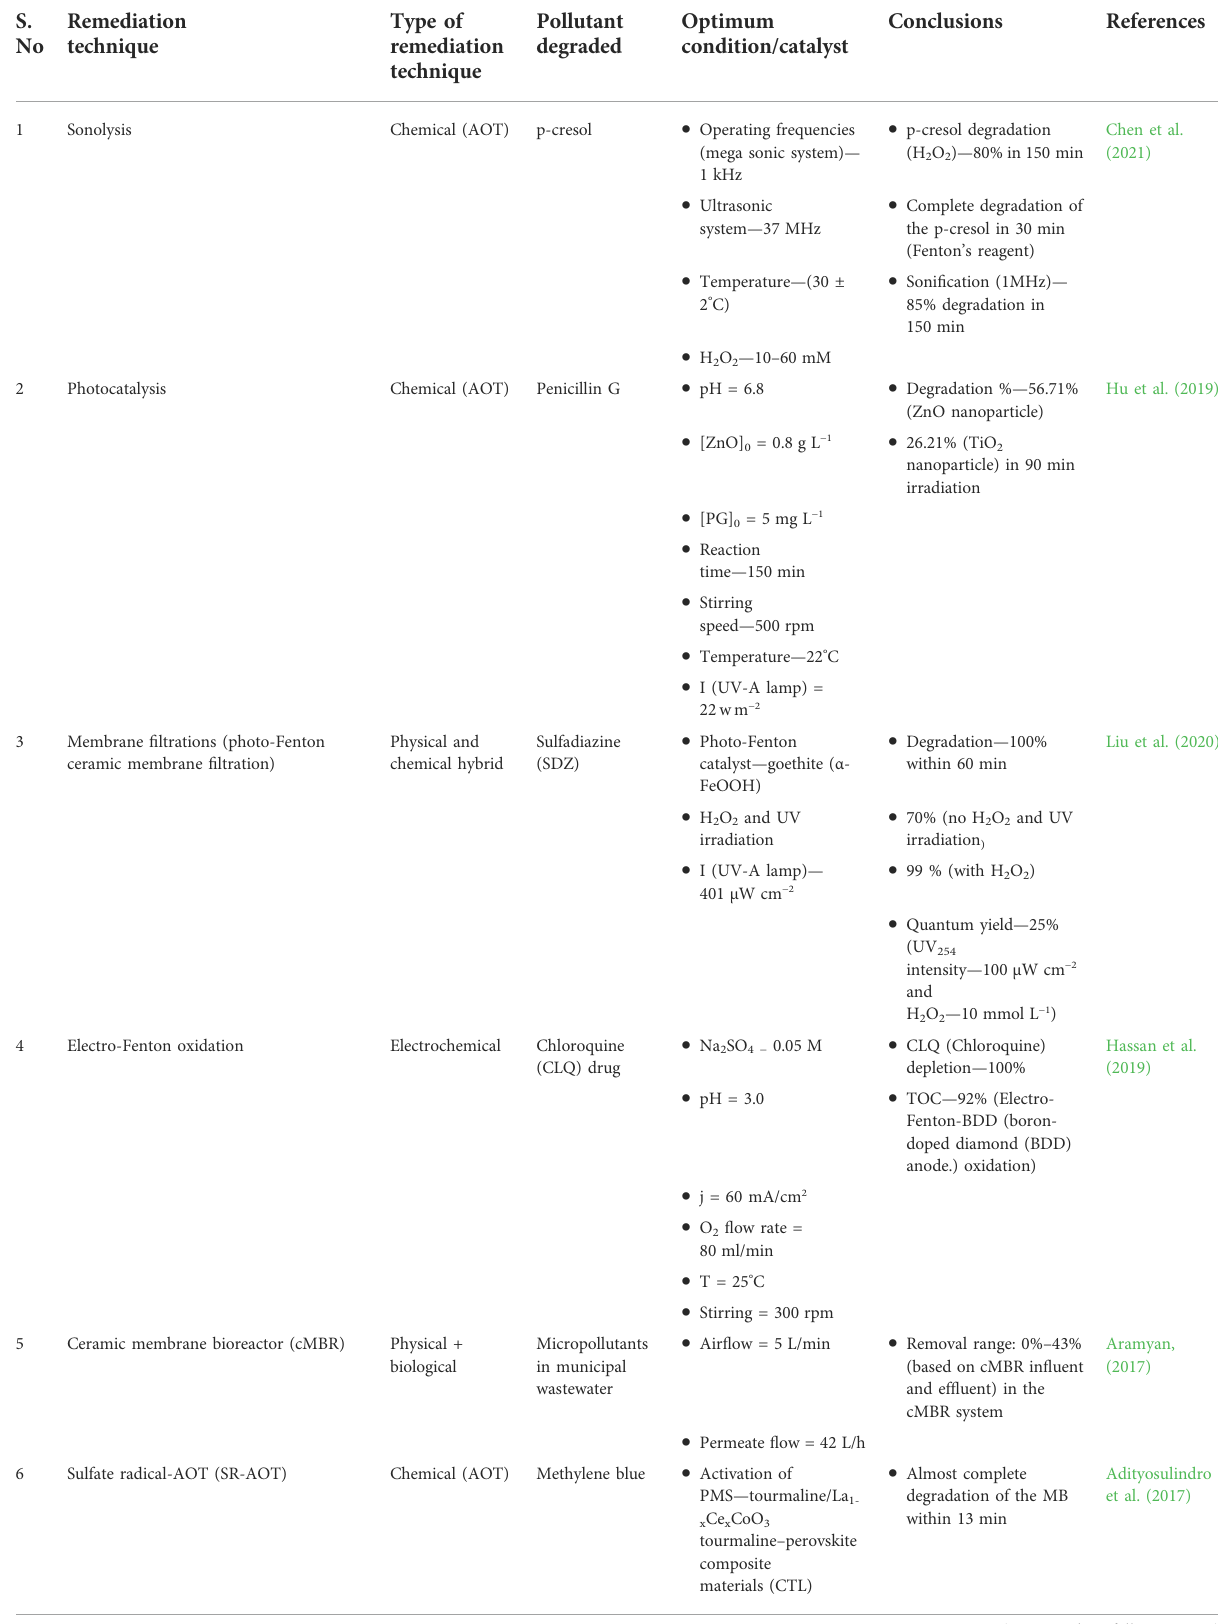
TABLE 2 Typical fi ndings observed in the degradation of organic pollutants by using various remediation